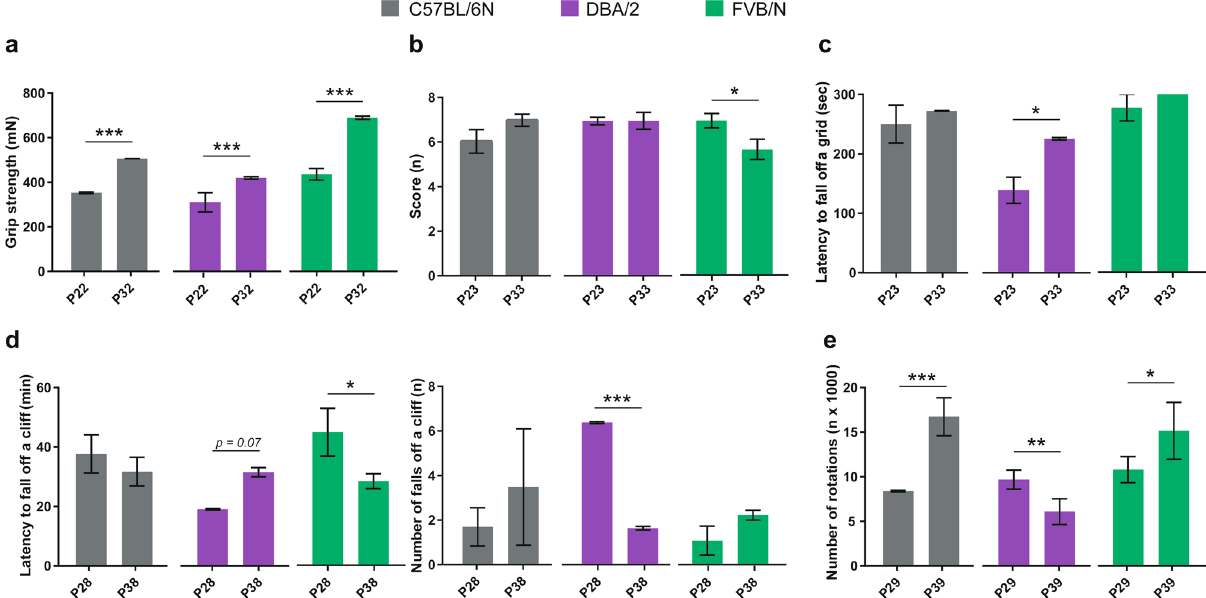
Figure 5. Comparison between the P22–30 and P32–40 cohorts within C57BL/6N, DBA/2, and FVB/N strains. ( a ) The grip strength was increased with age in the three investigated strains. ( b ) In the beam balance rod test, only FVB/N mice showed a decreased score in older mice. ( c ) The latency to fall off a grid in the inverted screen test was increased in older DBA/2 mice. ( d ) In the cliff avoidance reaction test, FVB/N mice exhibited